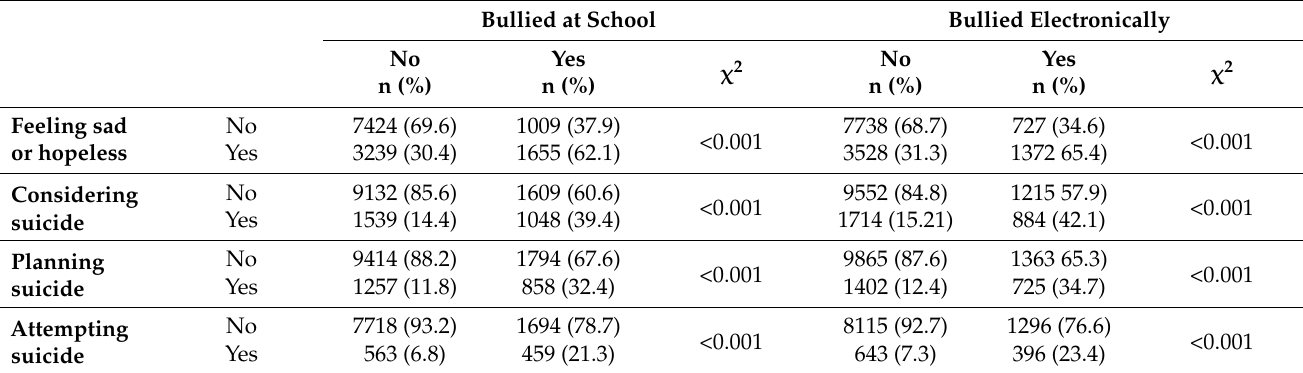
Table 3. Chi-square ( χ 2 ) analysis of the association of being bullied with mental states. Bullied at School Bullied